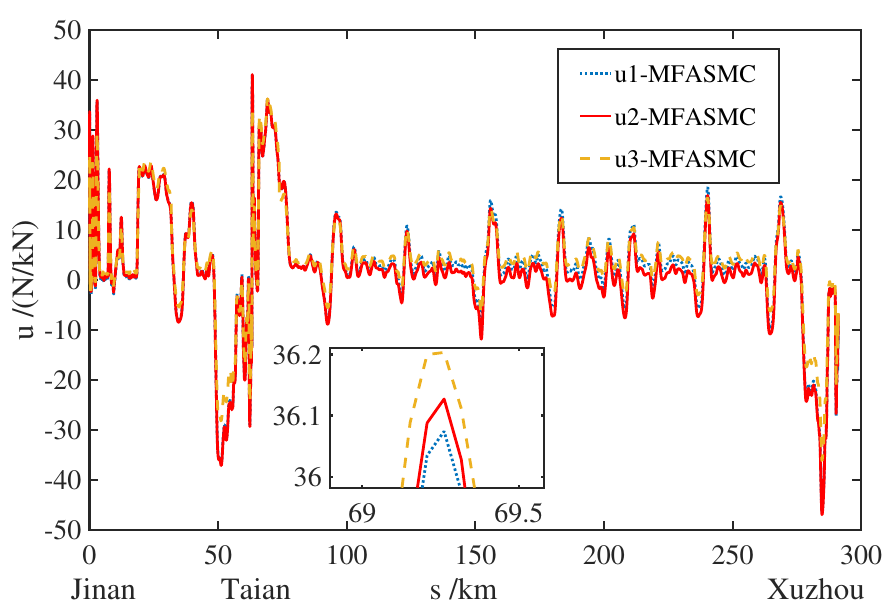
Figure 8. The control force distribution of each power unit of MFASMC.